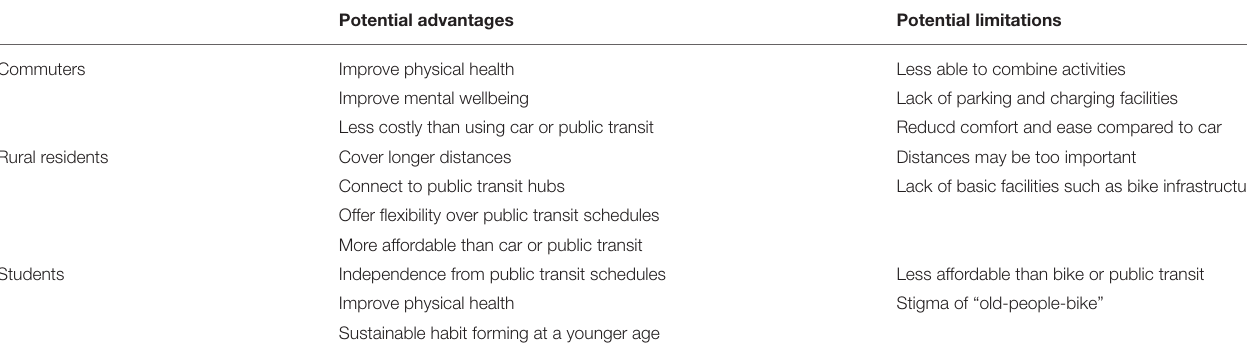
TABLE 1 | Potential advantages and limitations to e-bike use,